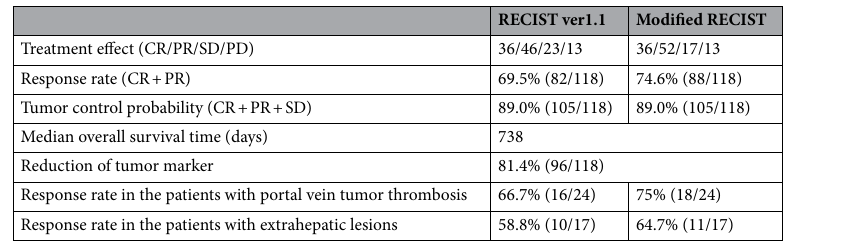
Table 2. Evaluation of treatment response after 3 courses of Ultra FP therapy from initial Ultra FP